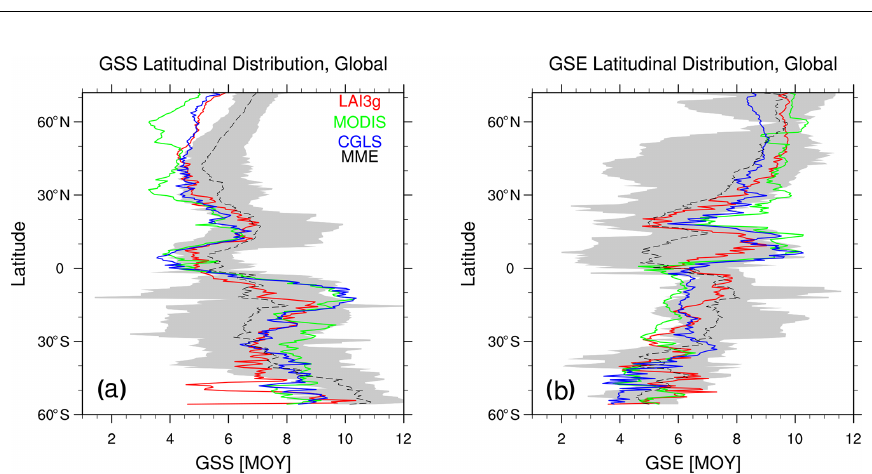
Figure 6. Zonal mean (a) growing season start (GSS) and (b) growing season end (GSE) timings for LAI3g (red lines), MODIS (green lines), CGLS (blue lines), and multi-model ensemble mean (black dashed line). The grey regions show the multi-model ensemble spread. Values are reported as month of the year (MOY), and the latitudinal coverage goes from 56 ◦ S to 75 ◦ N, which is the range covered by CGLS.